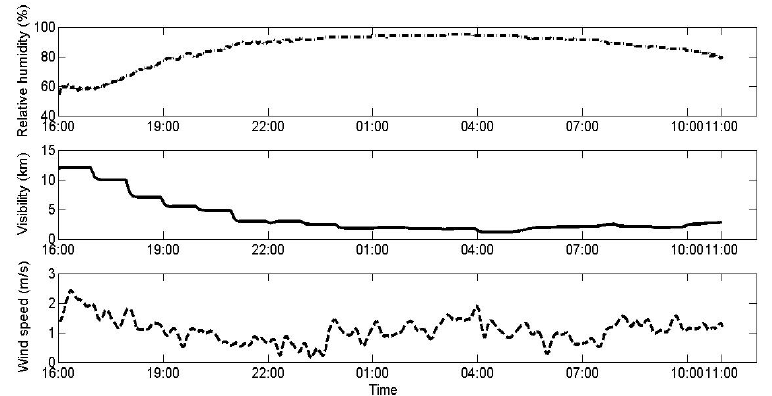
Figure 1. Evolution of relative humidity, visibility, and wind velocity during the haze episode.